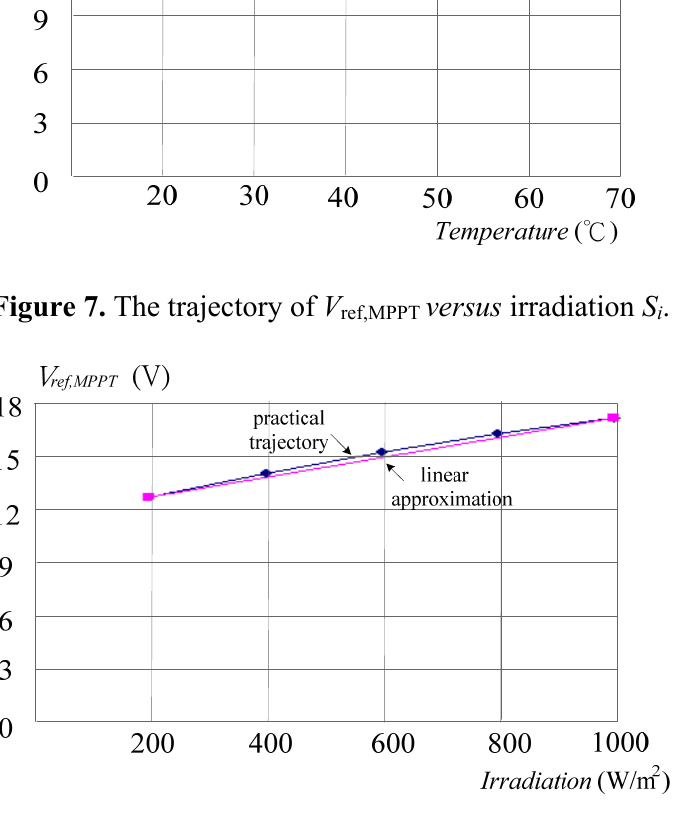
versus temperature T . ref, MPPT